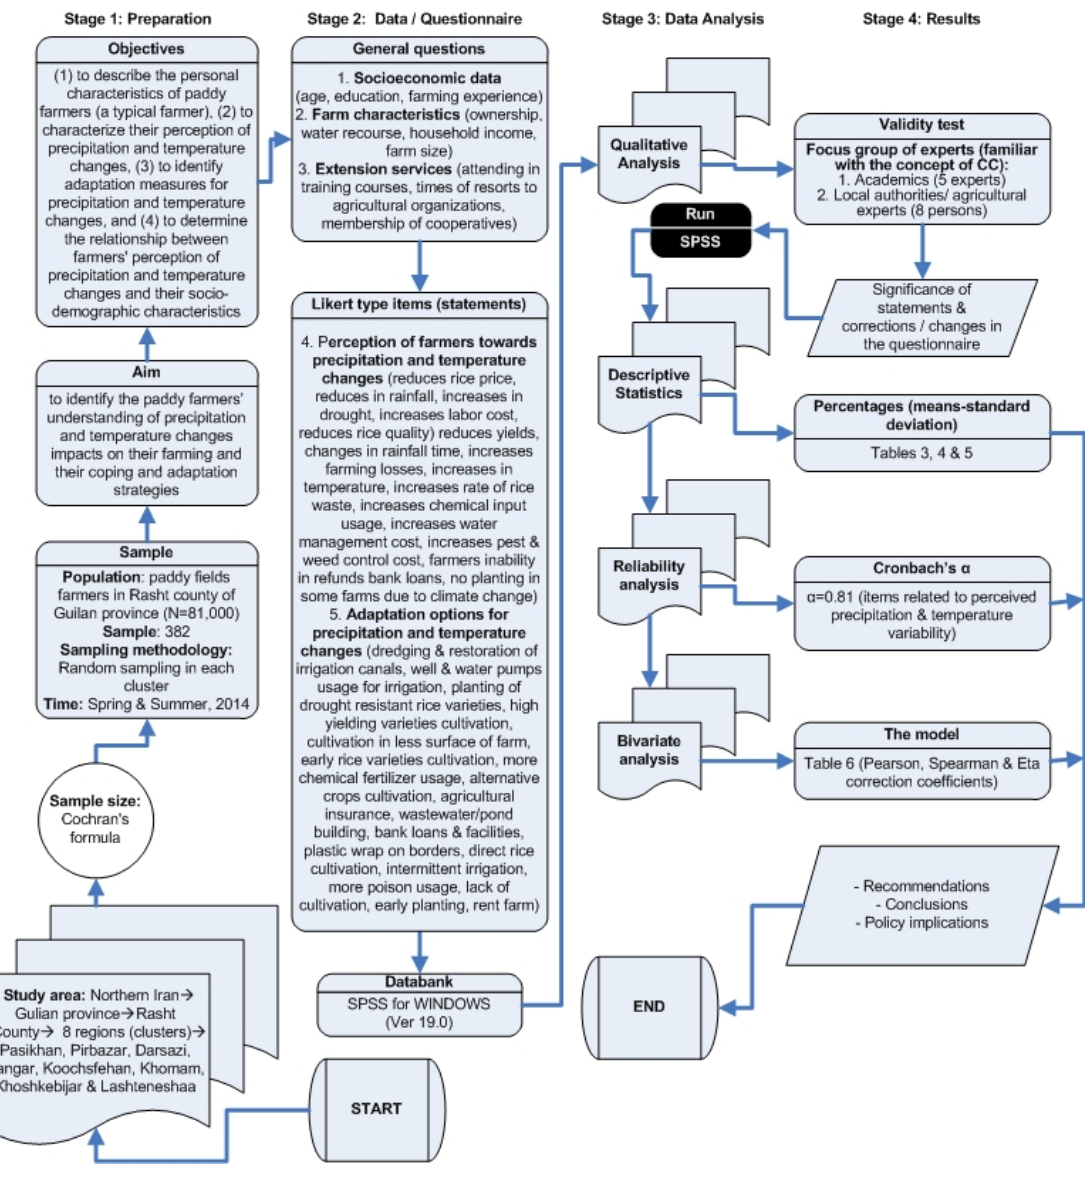
Figure 1. Methodological framework.